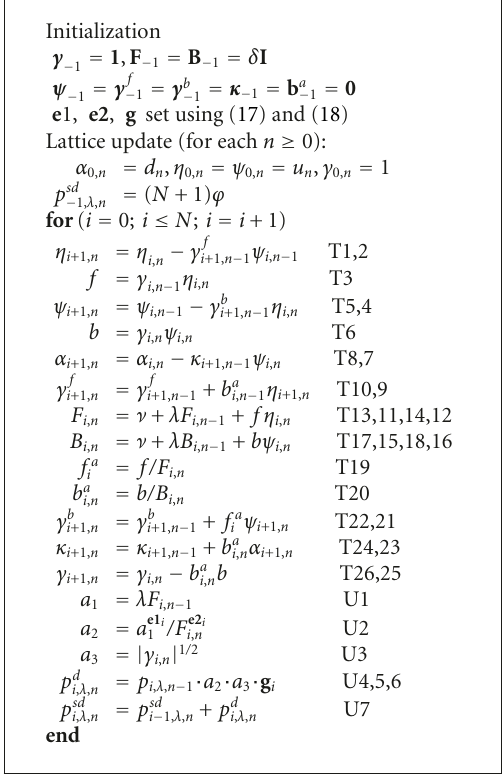
Algorithm 1: RLS lattice algorithm with exponential forgetting